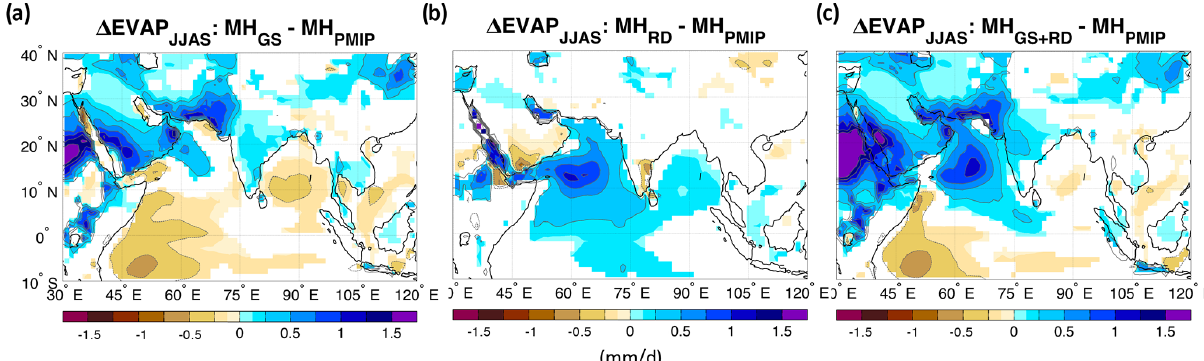
Figure A8. Changes in summer (JJAS) evapotranspiration (EVAP; mm/d) for (a) the mid-Holocene Green Sahara (MH GS ); (b) the dust- only reduction (MH RD ); and (c) the Sahara greening and dust reduction (MH GS + RD ) experiments relative to the mid-Holocene-only orbital forcing (MH PMIP ) simulation. The contour lines follow the color-bar scale (the 0 lines are omitted for clarity). Only differences significant at the 95% confidence level using the Student t test are